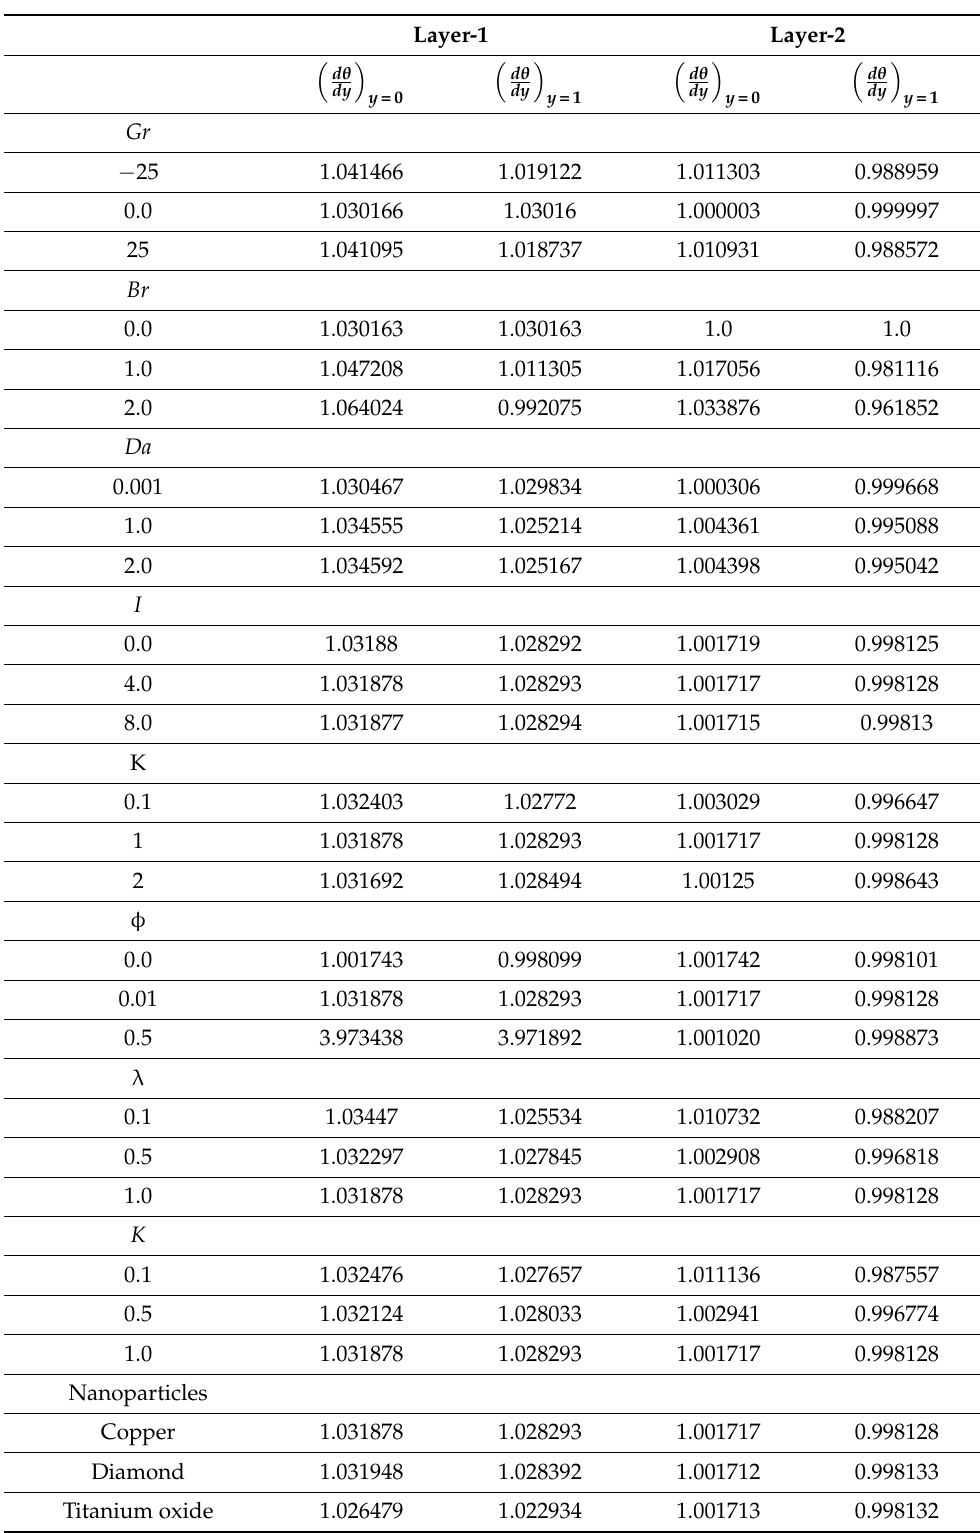
Table 5. Average Nusselt